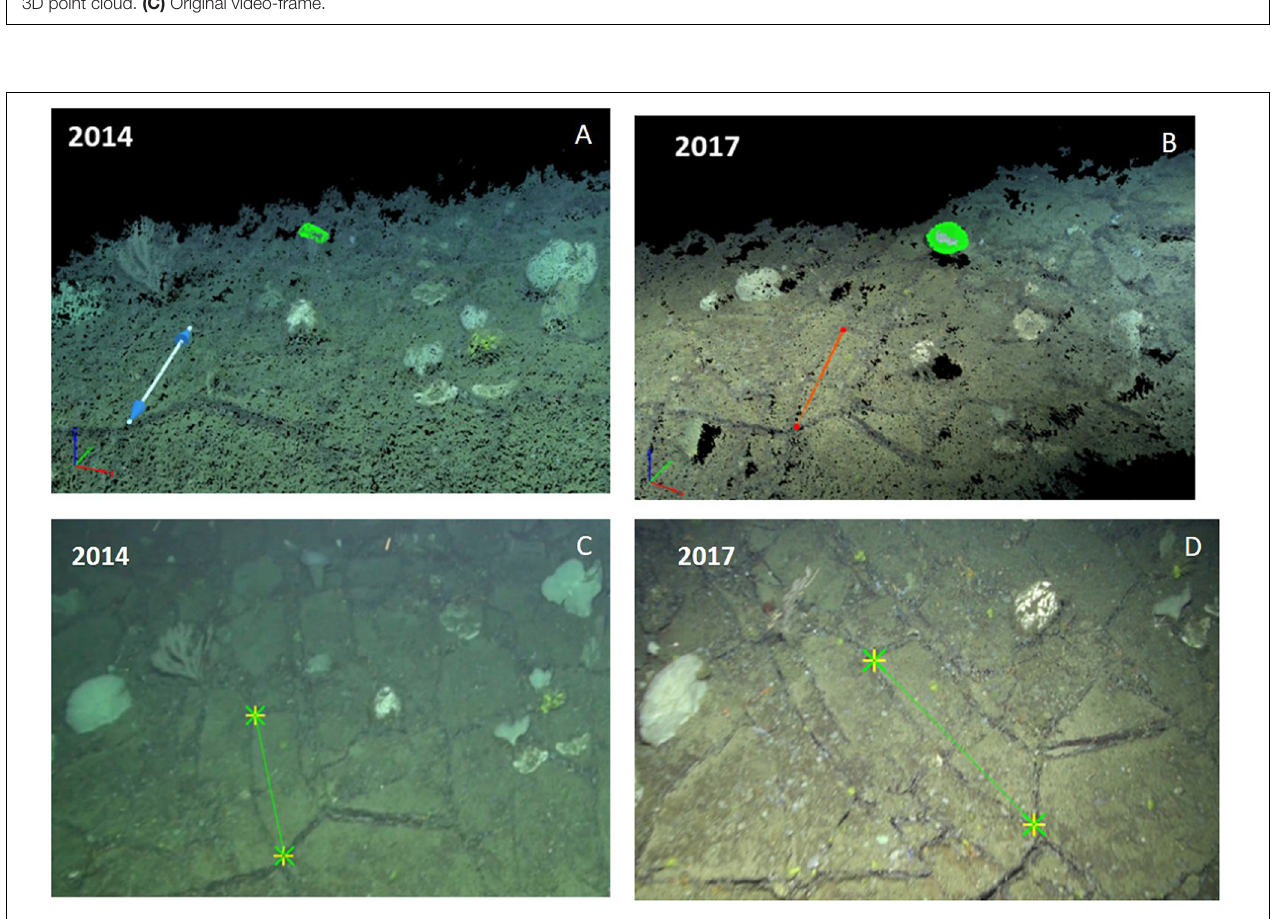
FIGURE 4 | Example of one of the 3D point clouds of an A. setubalense sponge used in this study. (A) View of the 3D point cloud. (B) Detail of A. setubelense in the 3D point cloud. (C) Original video-frame.